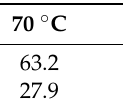
Table 5. Interface resistance of the Hot-pressed Group and the Reference Group at different tempera- tures ( Ω · cm 2